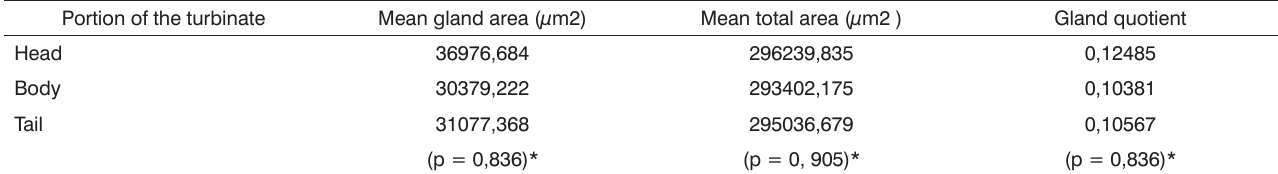
Table 1. Mean values of gland area, the total area of the lamina propria and the gland quotient in the head, body and tail of the lower nasal